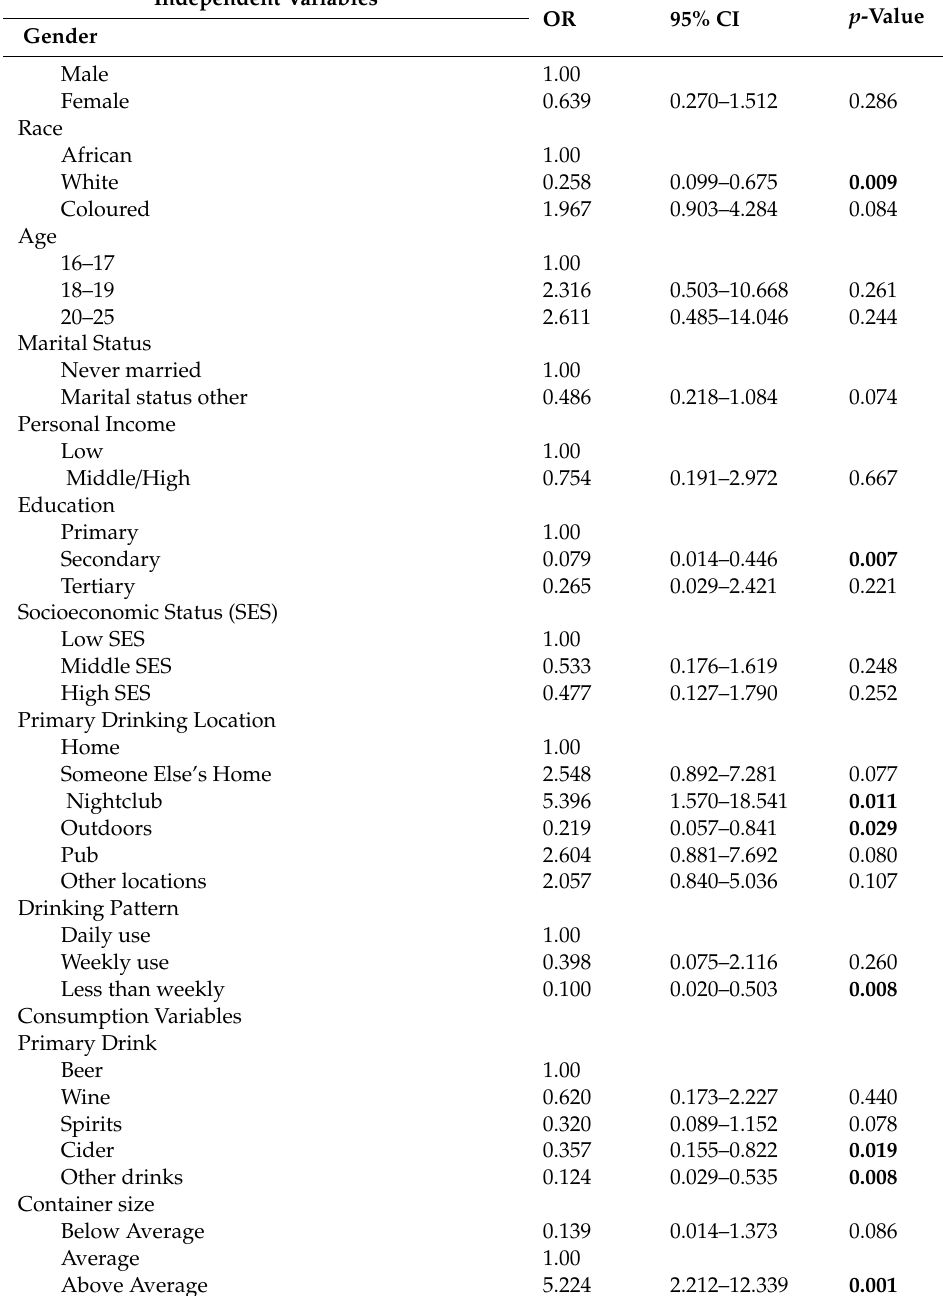
Table 2. Univariate logistic